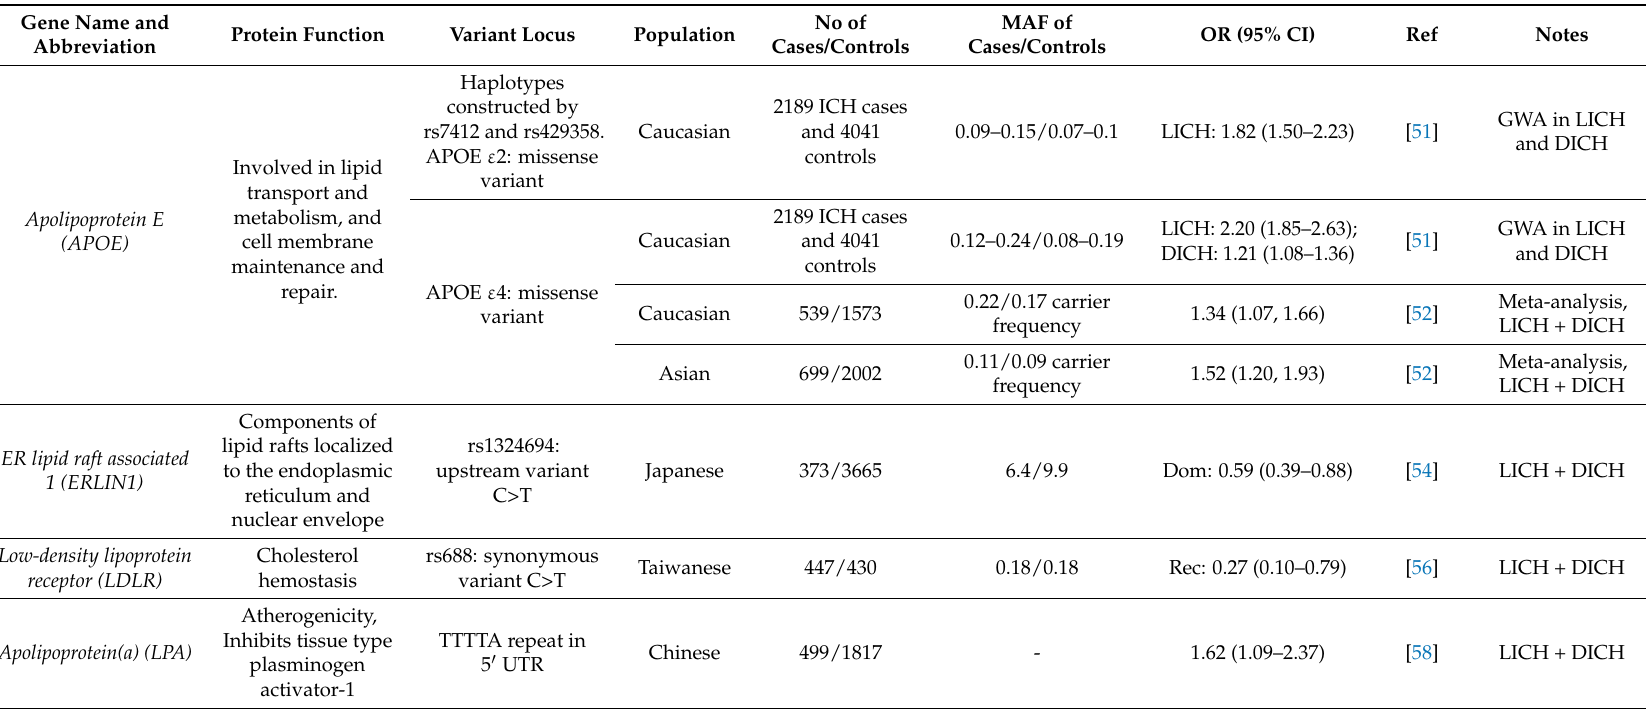
Table 2. Variants associated with ICH: lipid